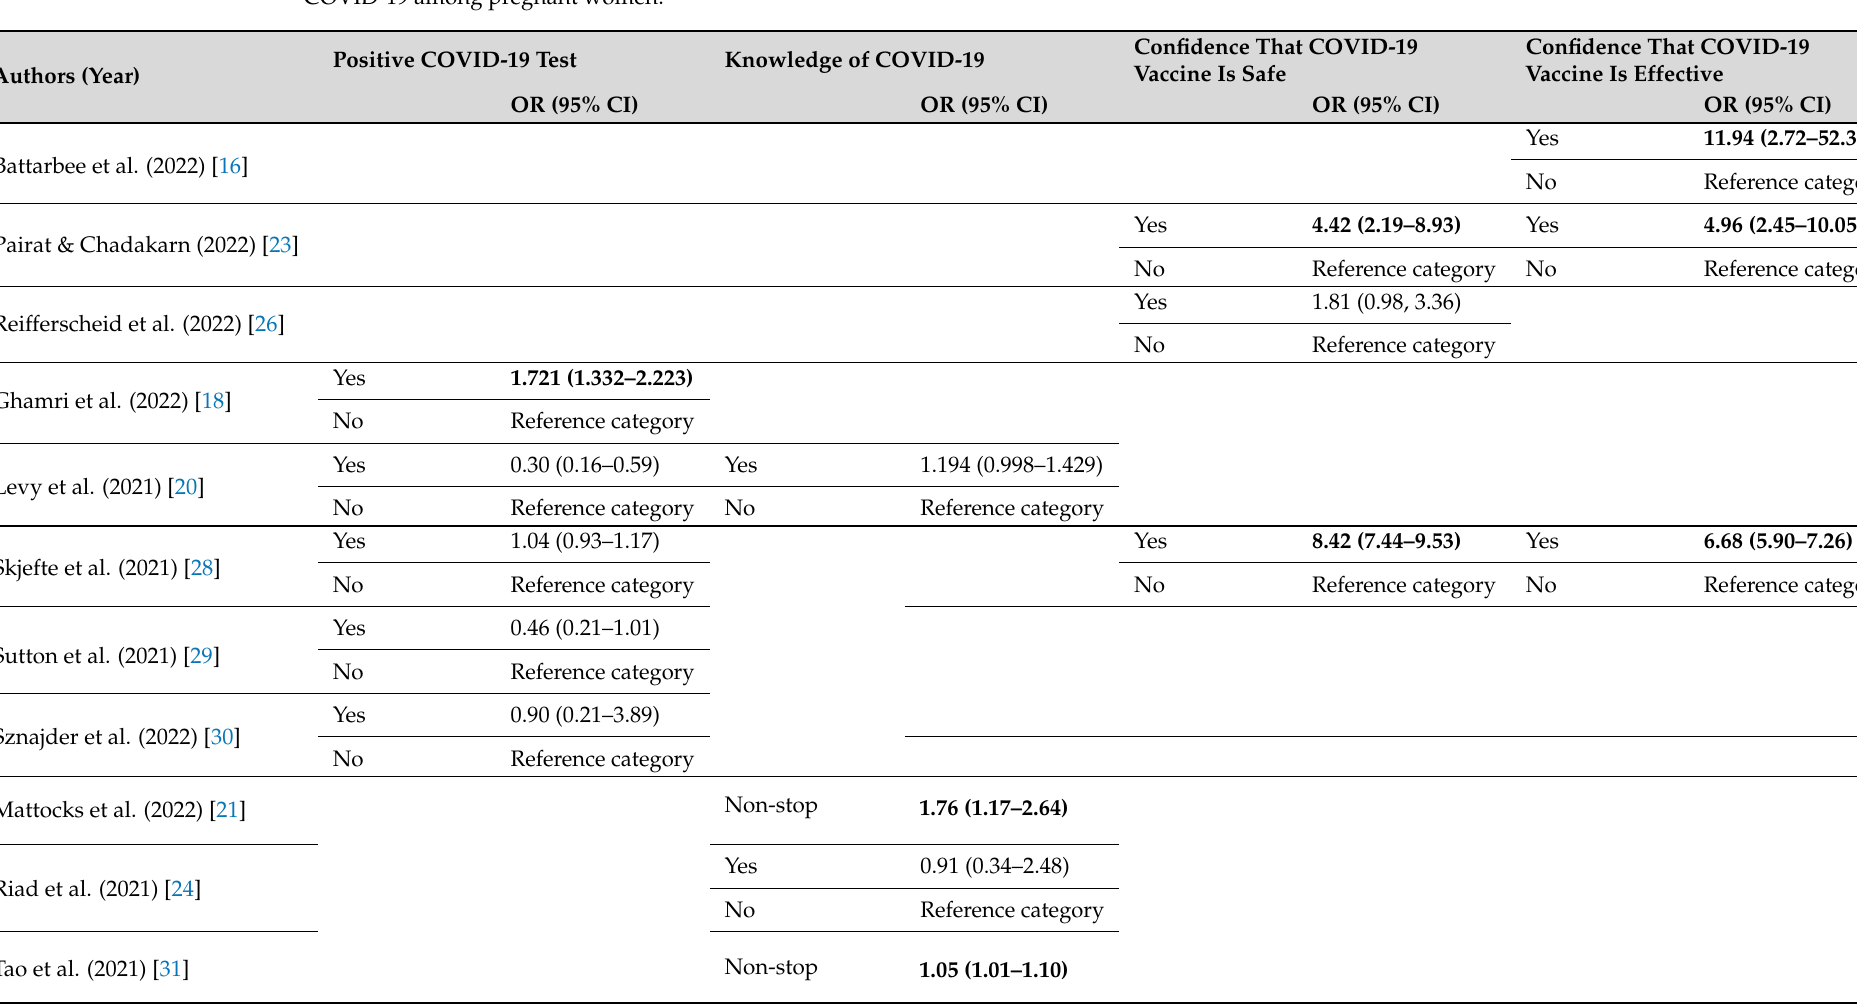
Table 4. Positive COVID-19 test, knowledge of COVID-19, and confidence that vaccines are safe and effective as factors in acceptance of vaccination against COVID-19 among pregnant